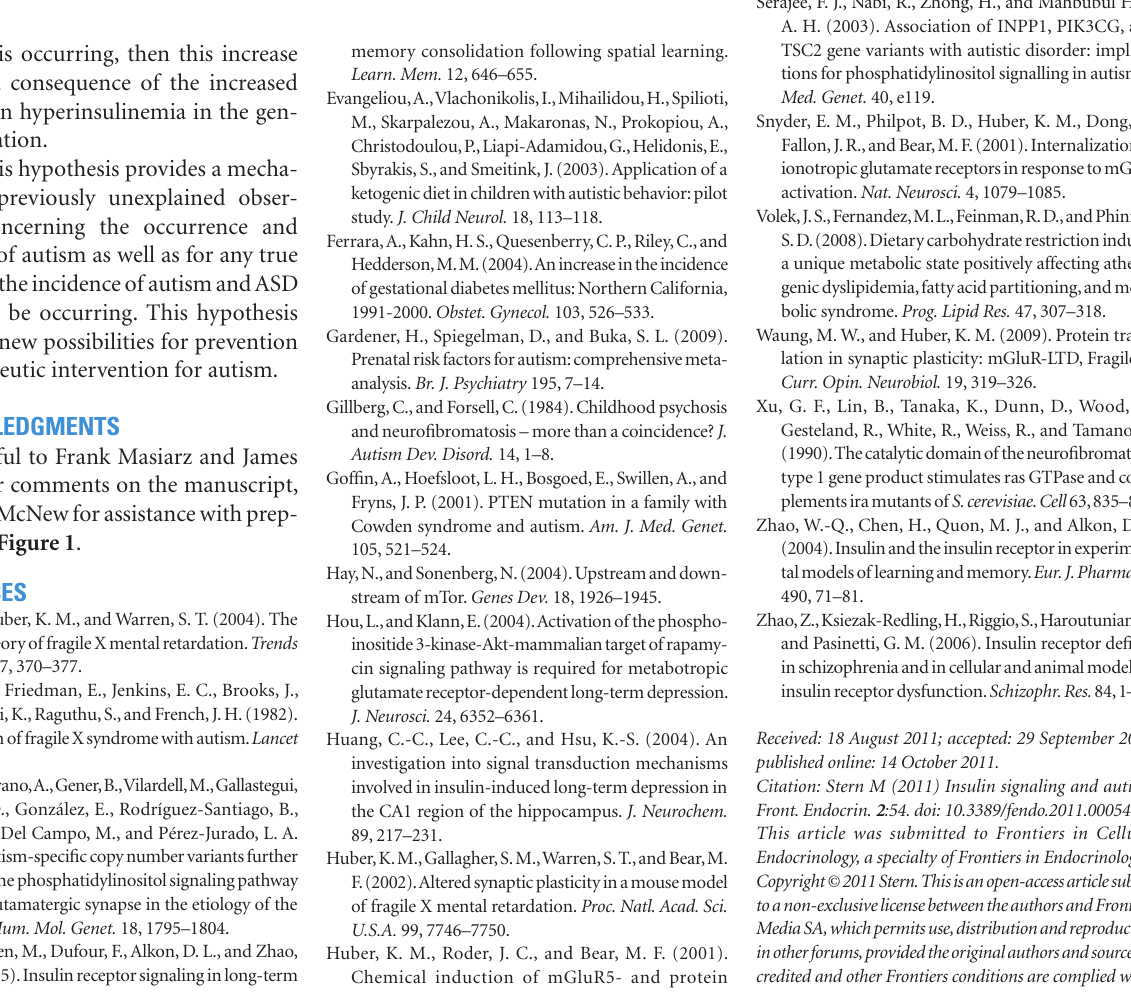
Figure 1 | Activation of the Pi3K/Tor pathway by insulin and glutamate. The relationships among the genes described in the text are shown. Proteins shown in red are PI3K/Tor pathway inhibitors, and autism is associated with loss of function mutation in these genes, whereas the proteins shown in green are PI3K/ Tor pathway activators and autism is associated with gain of function alterations in these genes. Proteins shown in blue represent other pathway activators. For clarity, several molecular intermediates are omitted. See Hay and Sonenberg (2004) for a more complete molecular description of this